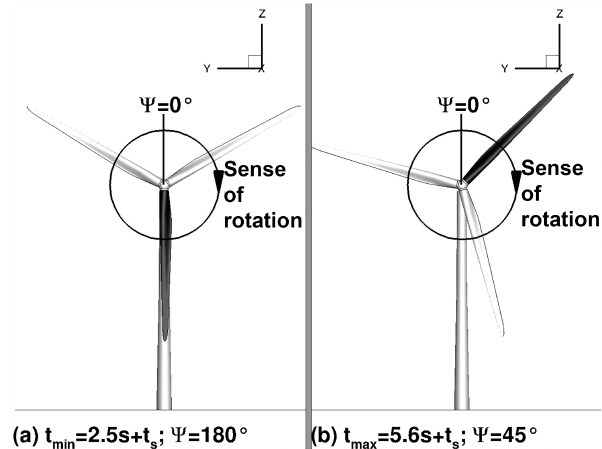
Figure 6. Rotor position at minimum (a) and maximum (b) gust velocity; black blade is blade number 1.